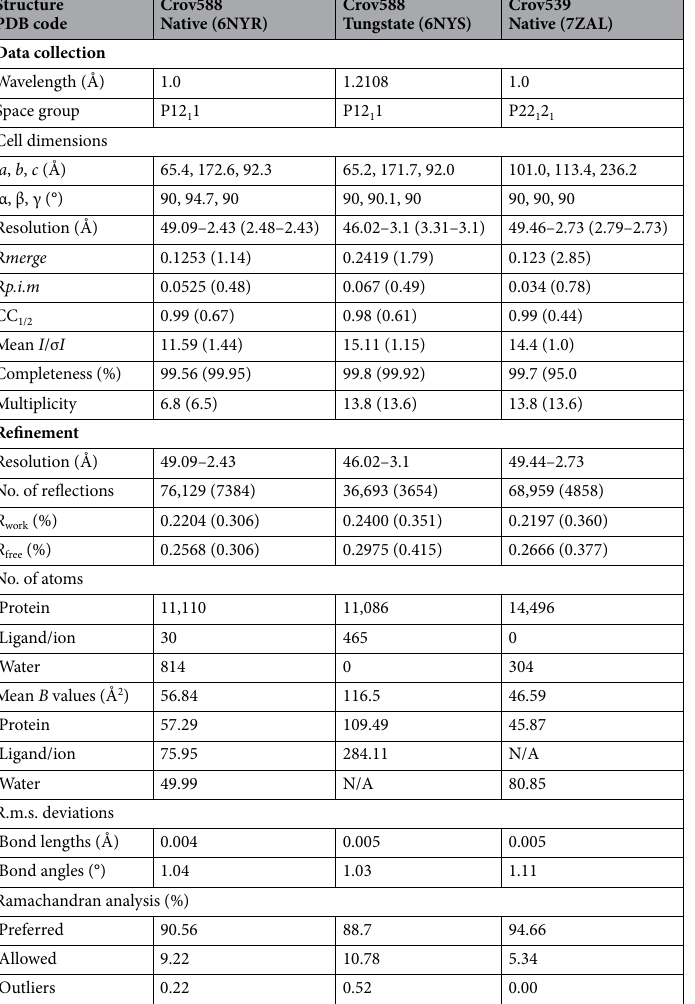
Table 1. Data collection and refinement